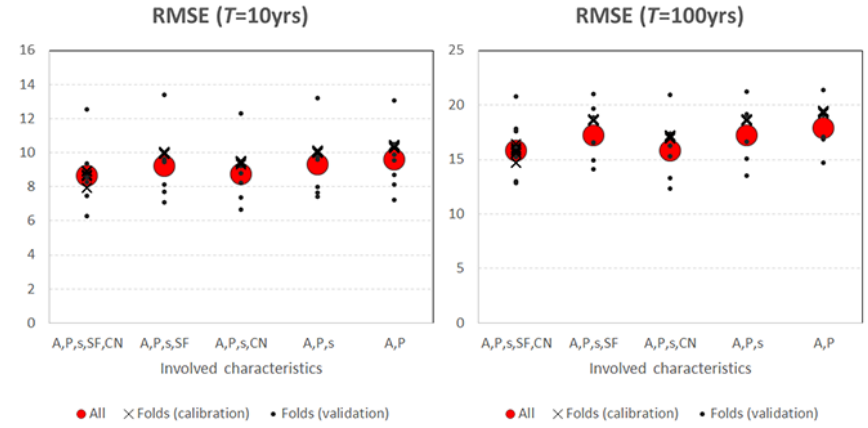
Figure 16. Values of root mean square error (m 3 s − 1 ) for calibration to the whole data set and for calibration and validation using 7 folds for T = 10 years (left panel) and T = 100 years (right panel).